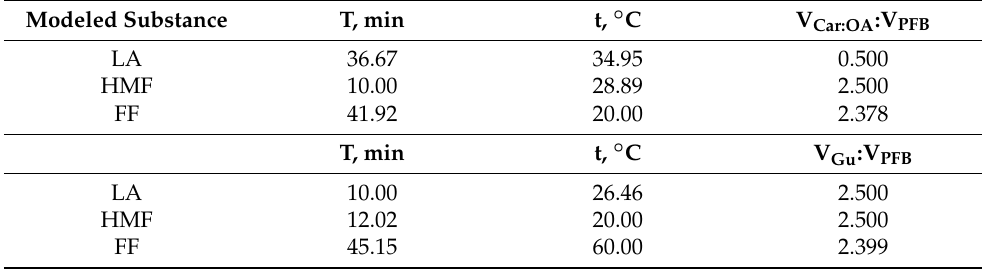
Table 4. The process parameters allowing to obtain optimal values calculated via RSM analysis. Modeled